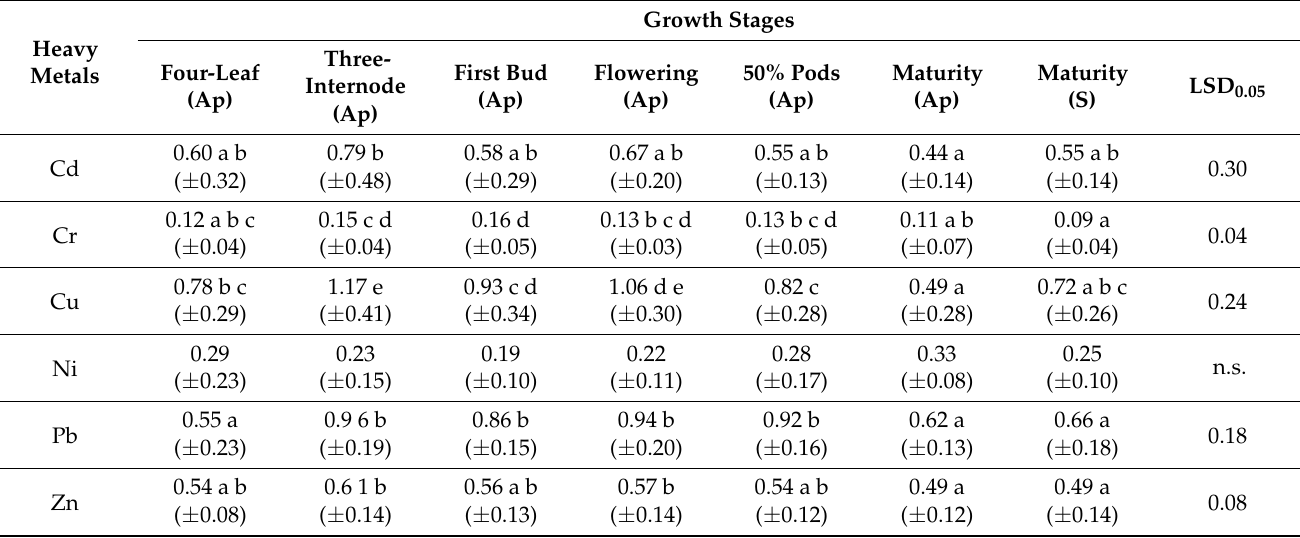
Table 11. TF of heavy metals to aerial parts (Ap) and seeds (S) of pea plants (mean values ± SD of two cultivars and two successive years with three repetitions